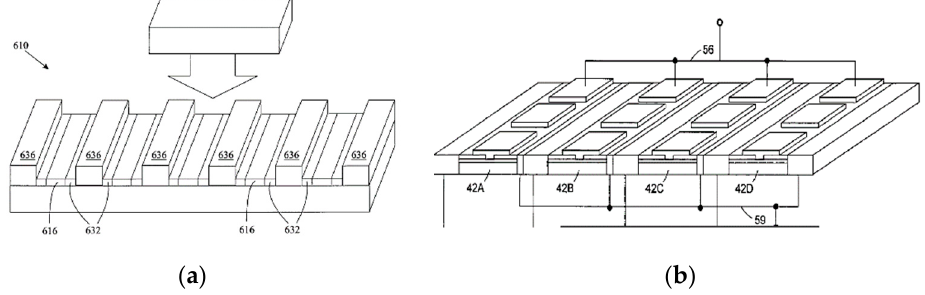
Figure 2. Plasmonic crystal concept: multi finger (grating gate) (from [14]) ( a ) and two-dimensional plasmonic array (from [15]) ( b ).